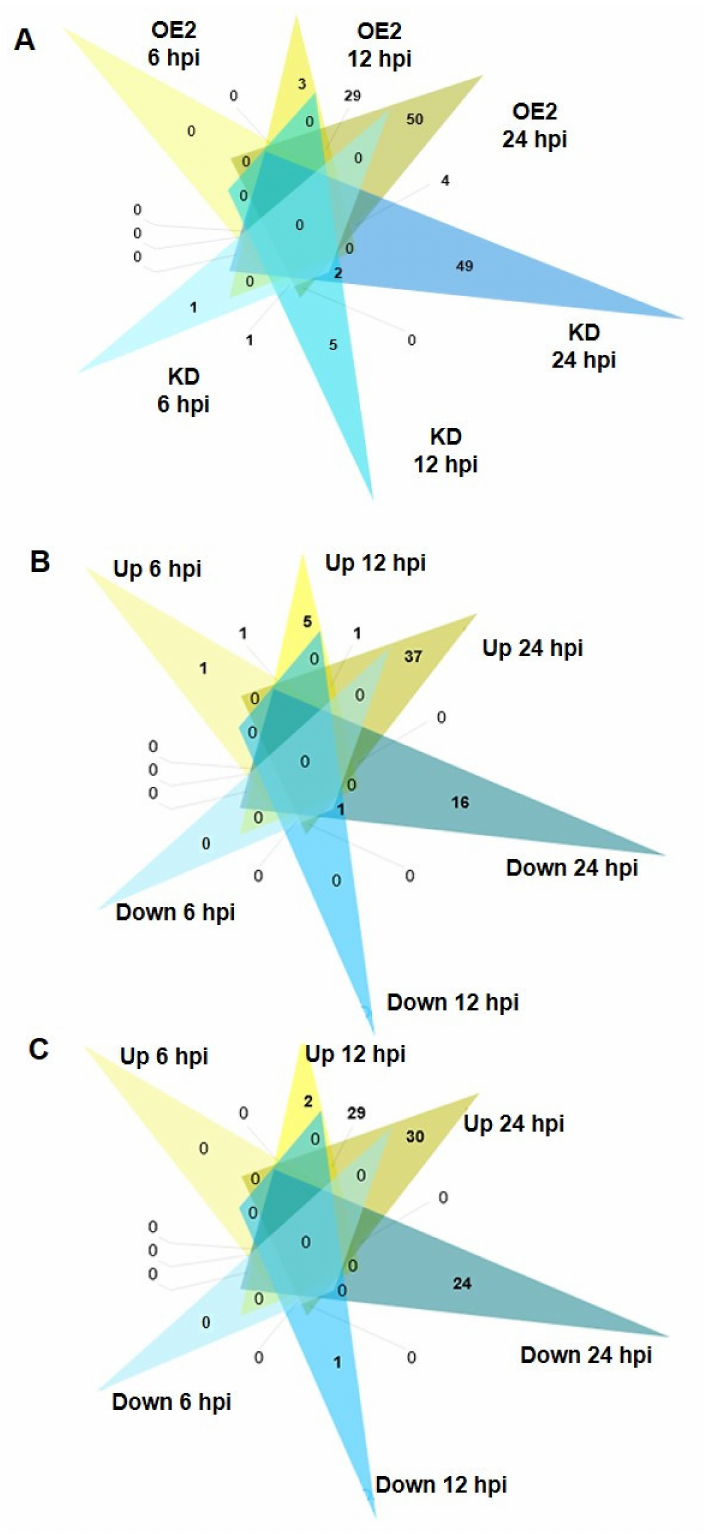
Figure 4. Number of differentially expressed genes in roots found specifically during an infection with Rs GMI1000 strain based on a 5% FDR. ( A ) Numbers in Venn diagrams indicate the number of DEGs found at each time point in the roots of CML8 KD (blue color) and OE2 plants (yellow color) compared to WT plants. ( B ) Number of up- (yellow) and down-regulated DEGs (blue) in roots specific to each time point of the kinetic or overlapping between time point in KD line. ( C ) Number of up- (yellow) and down-regulated DEGs (blue) in roots specific to each time point of the kinetic or overlapping between time point in OE2